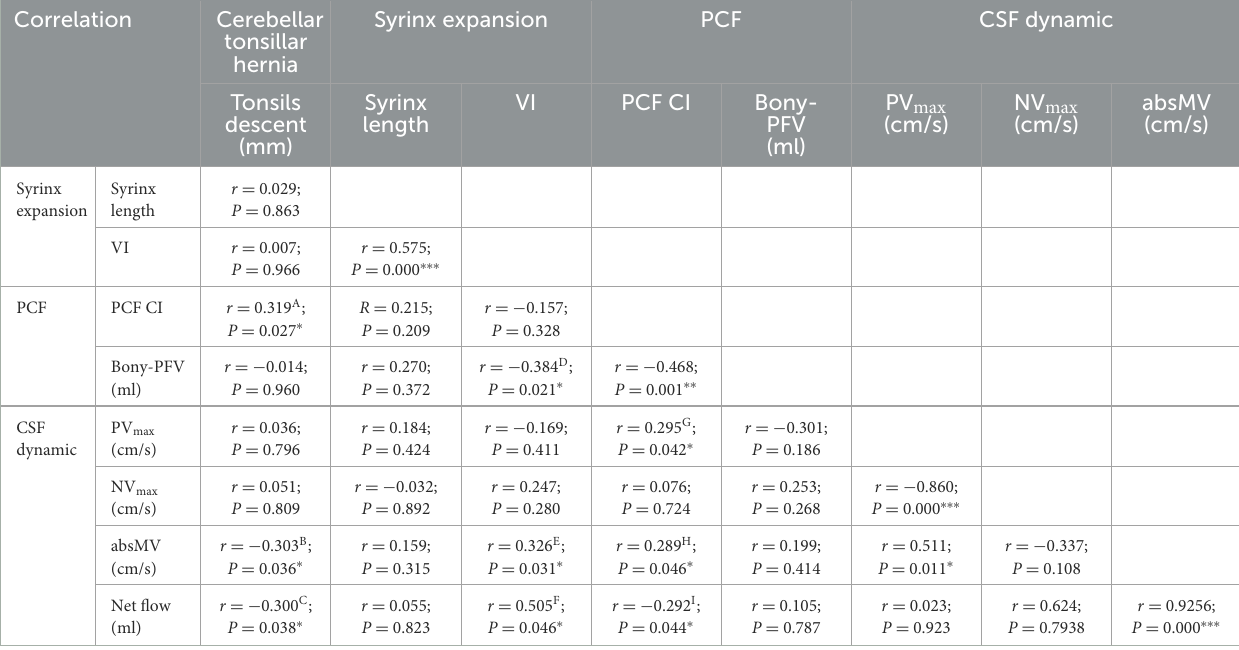
PCF CI Bony- PFV